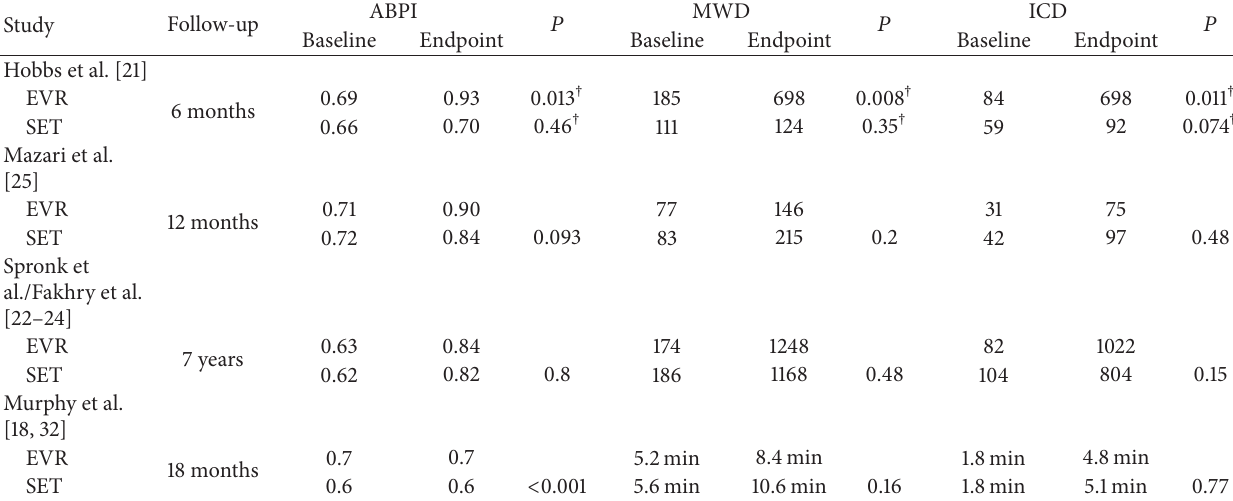
Table 3: Supervised exercise versus endovascular revascularization.